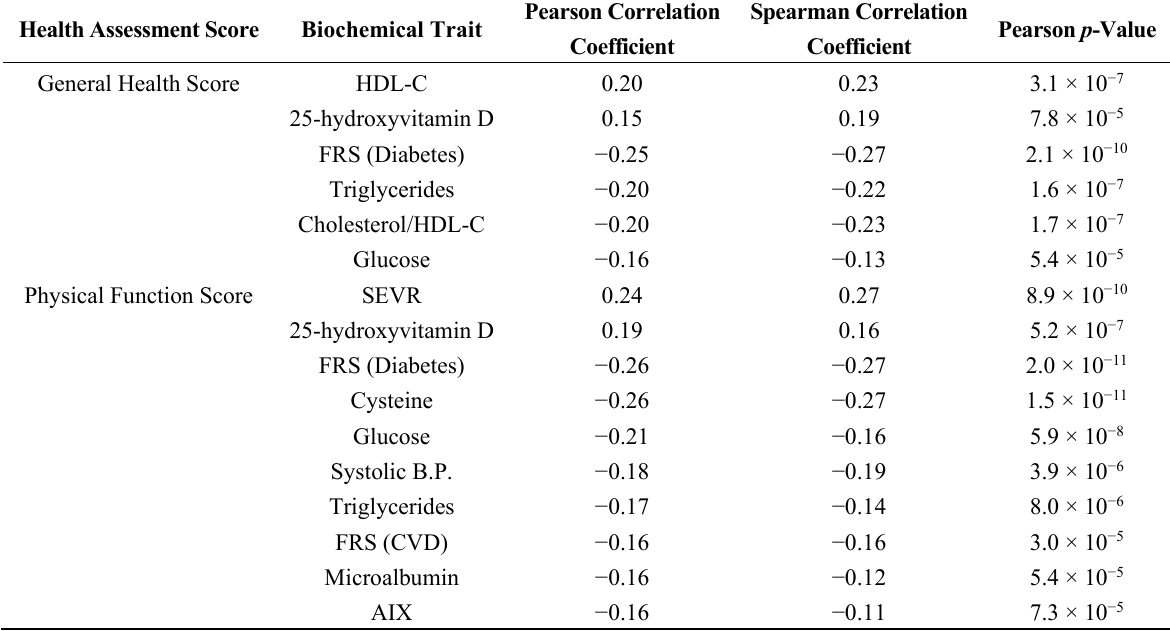
Table 2. Relationship between health assessment scores and biochemical measures in the entire CHDWB cohort (N = 668) at baseline.